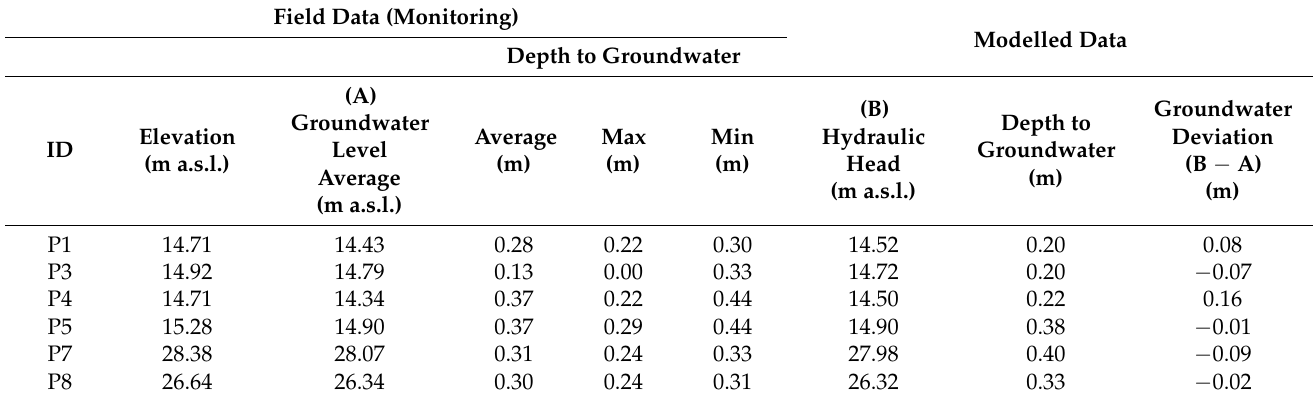
Table 3. Groundwater level measured against modelled values.